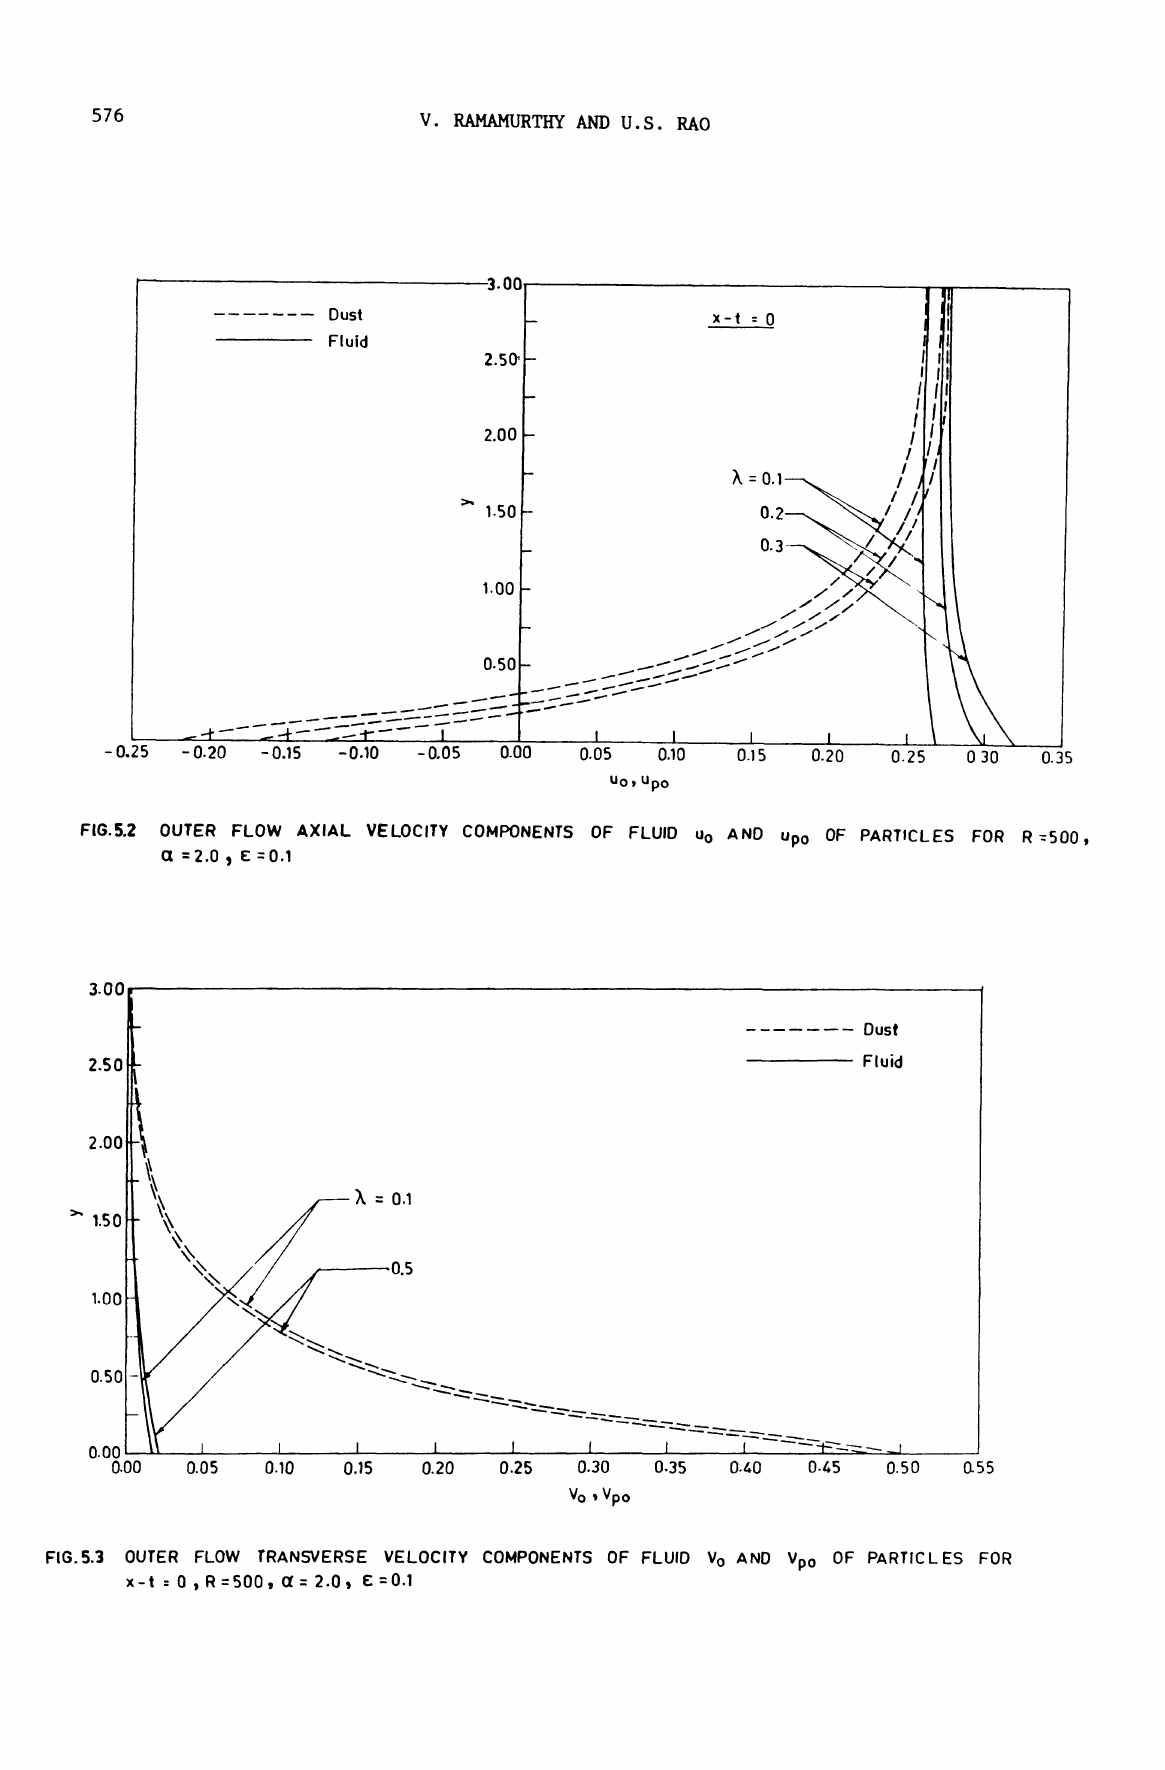
FIG. 5.3 OUTER FLOW TRANSVERSE VELOCITY COMPONENTS OF FLUID Vo AND Vpo OF PARTICLES FOR x-t 0,R=500, CX= 2.0,